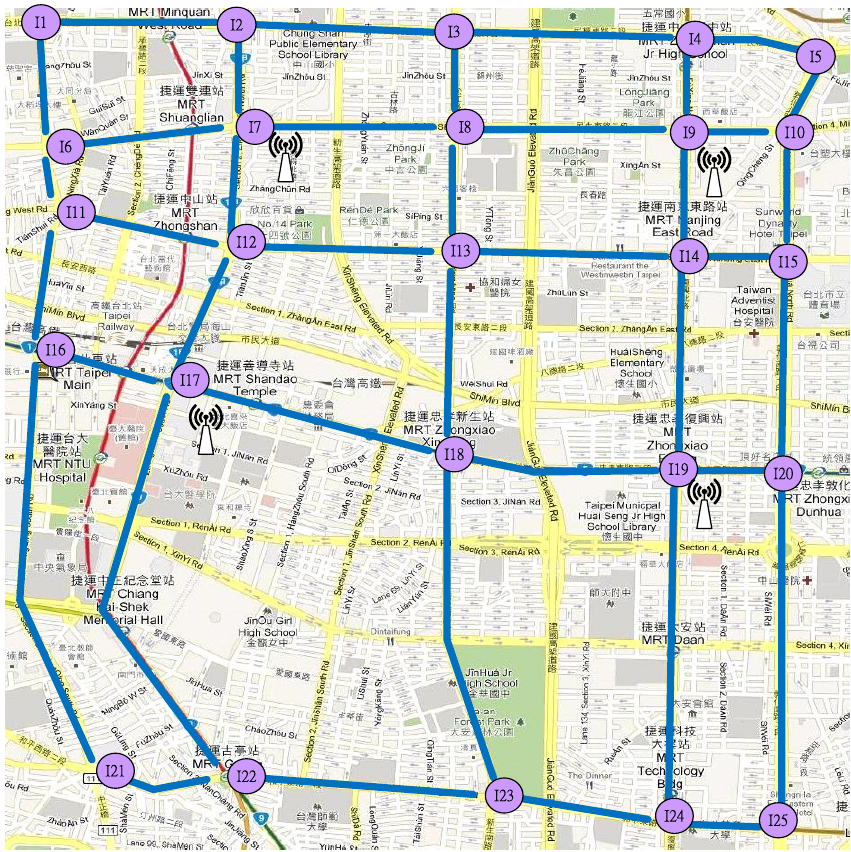
Figure 8. The experiment area used in simulations.